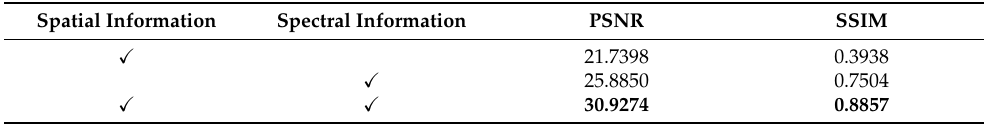
Table 5. The ablation experiment of F-3MTNN. Spatial